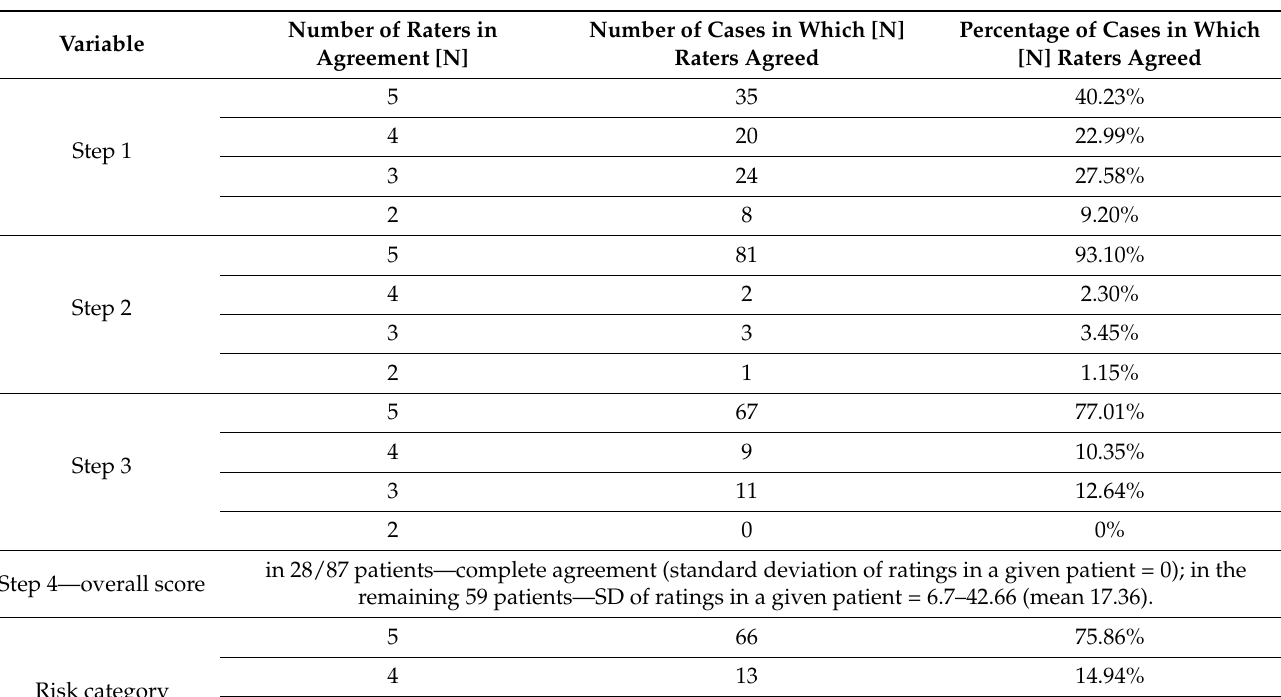
Table 2. Results of the basic analysis of inter-rater variability of the PRAETORIAN score.